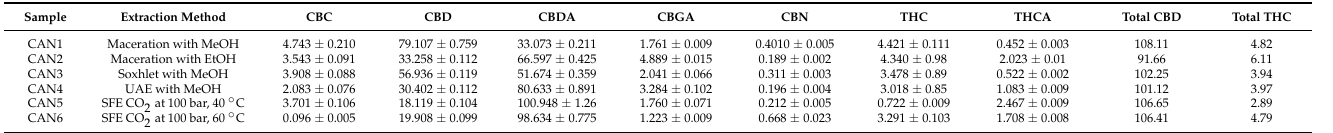
Table 1. Phytocannabinoids in Cannabis sativa extracts analysed by LC-MS/MS. Data are expressed as mg/g (mean, n = 3 ± SD). Total CBD and THC are calculated as the sum of natural form, plus acid form, multiplied by conversion factor 0.877 to account for the loss of CO 2 molecule during the decarboxylation.